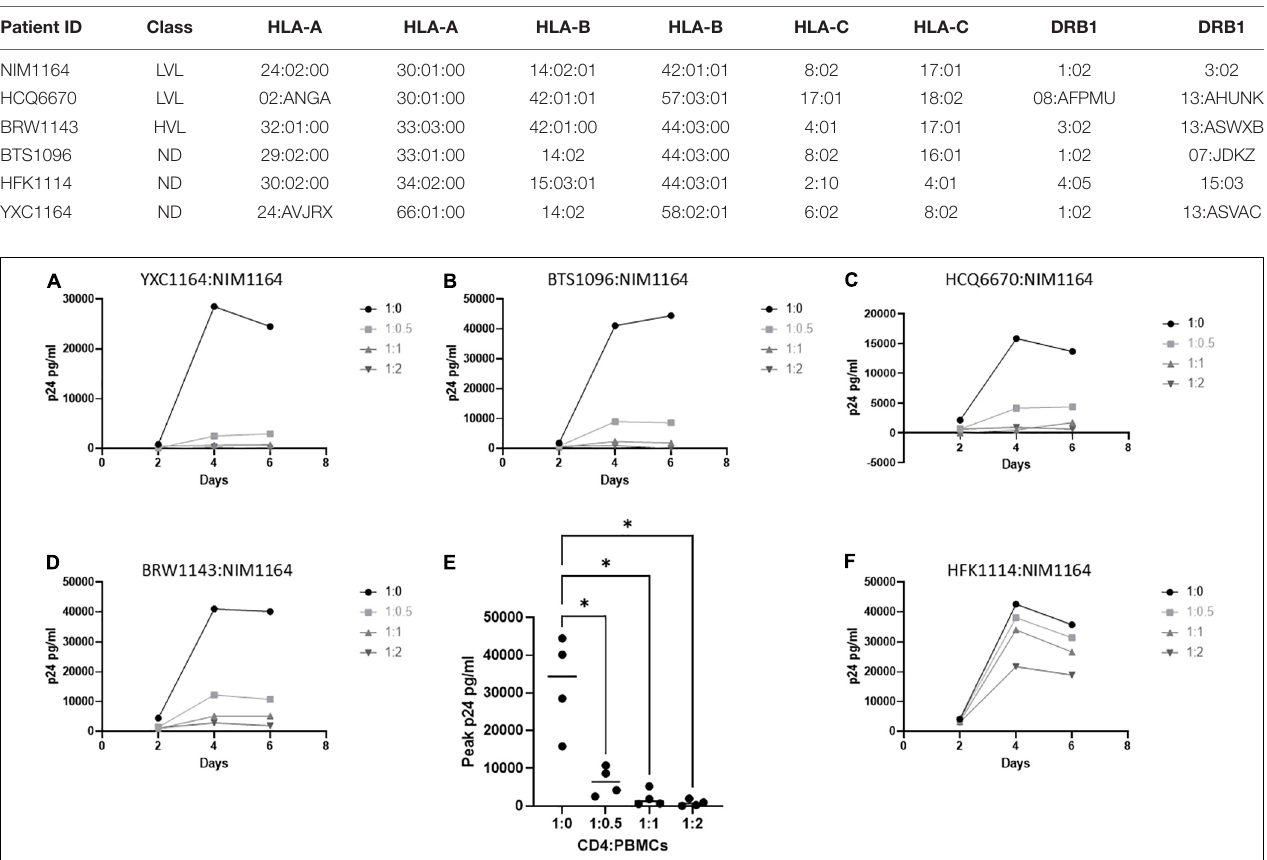
TABLE 2 | HLA typing of subjects.